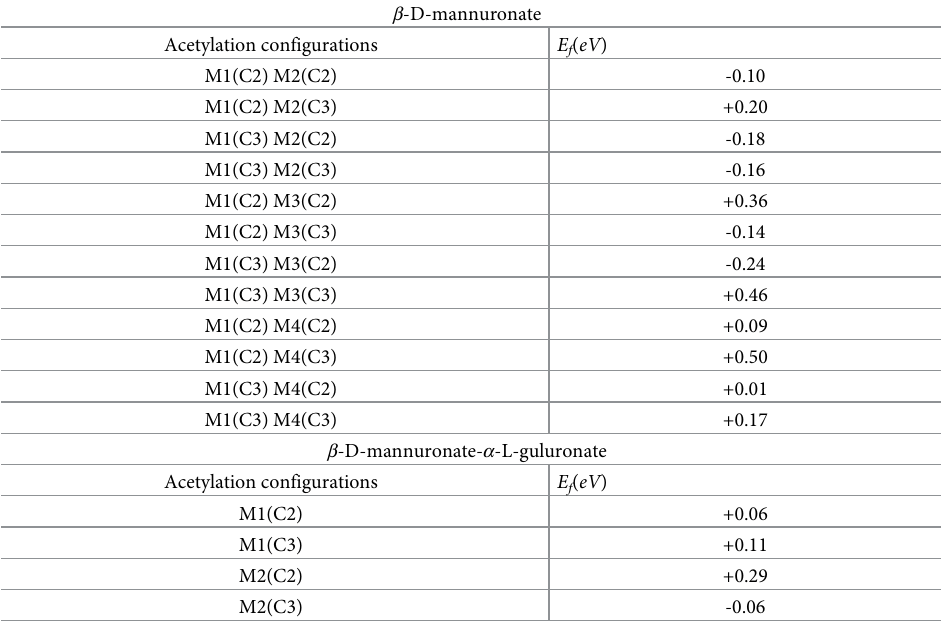
Table 1. Formation energies (eV) of the different acetylation configurations, using nomenclature outlined in Fig 1, for each polyuronate